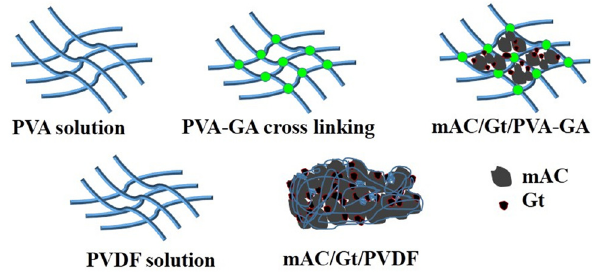
Figure 1: Schematic illustration of mAC/Gt/PVA - GA and mAC/Gt/PVDF